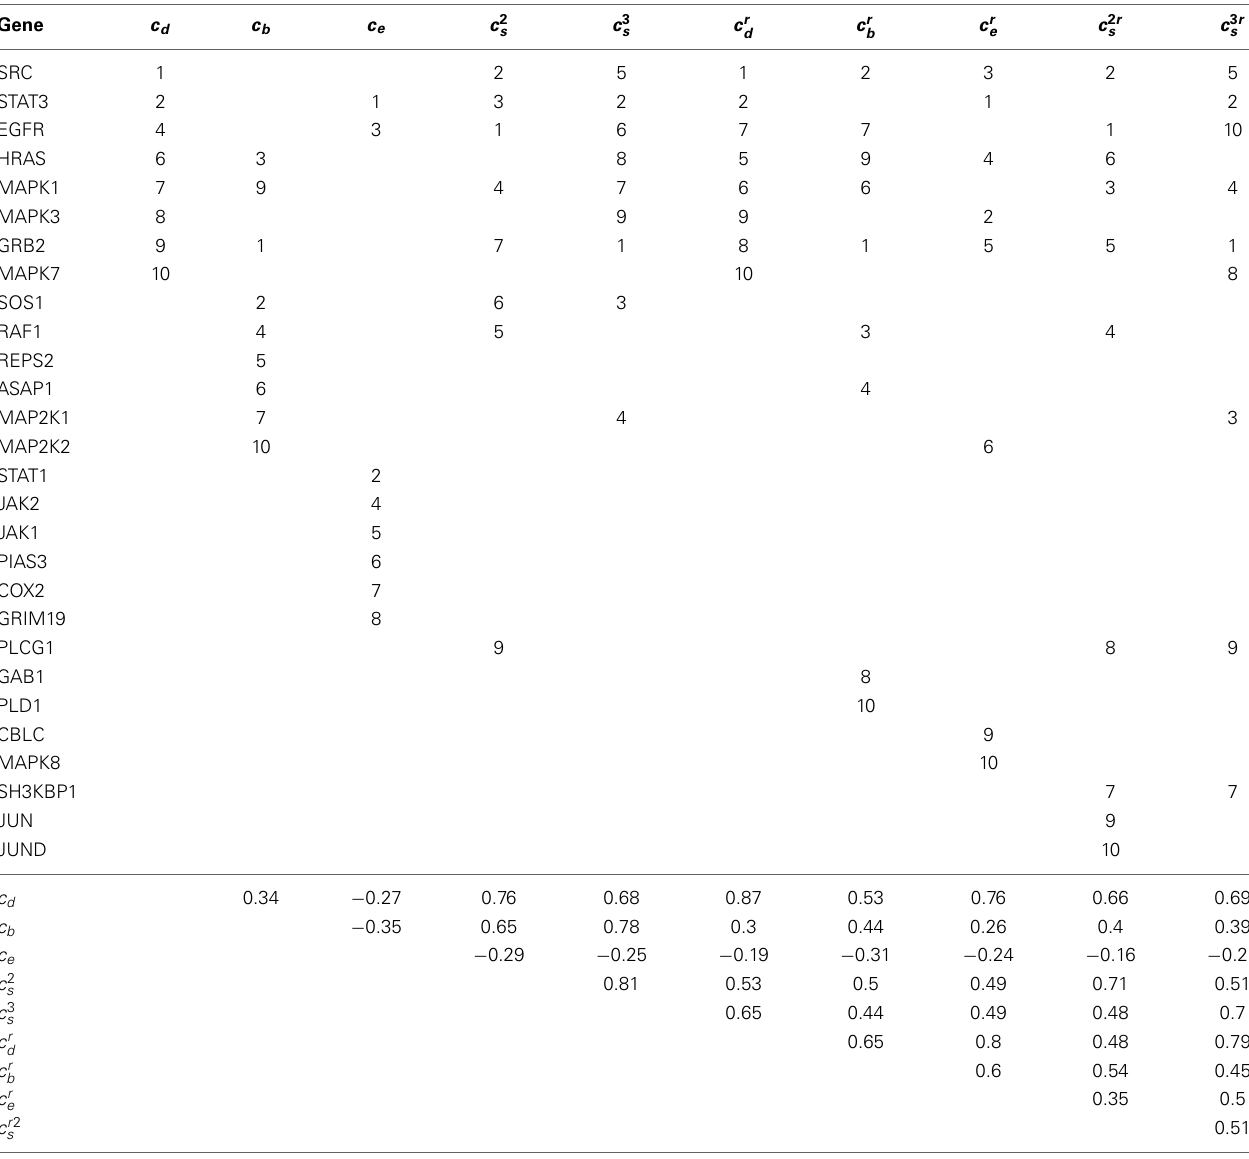
Table 2 | Top ranking genes in EGFR pathway by various centrality measures.